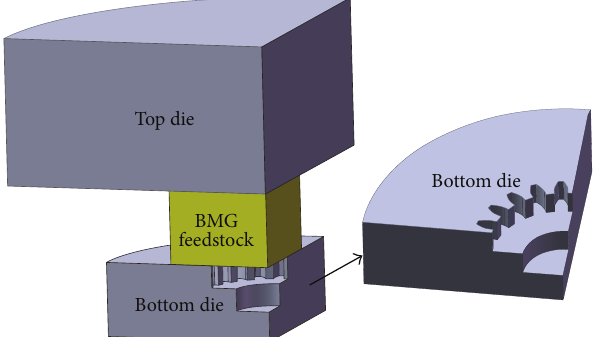
Figure 2: Simulation model for hot embossing of BMG microgear.